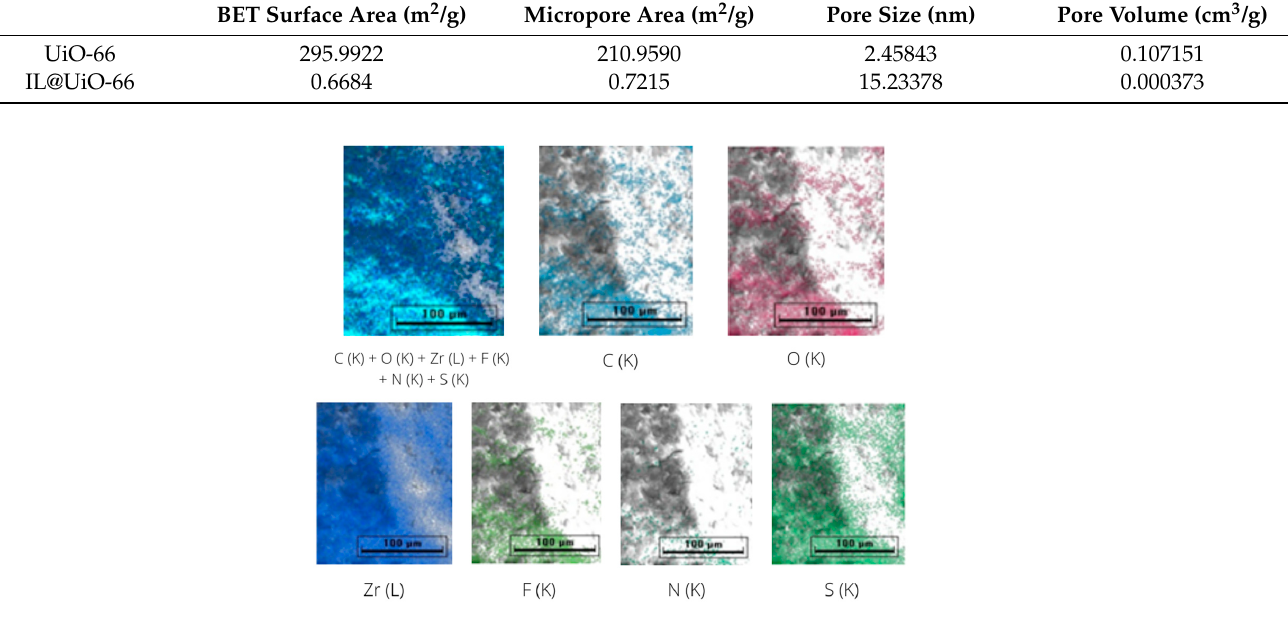
Figure 7. EDX mapping of IL@UiO-66.